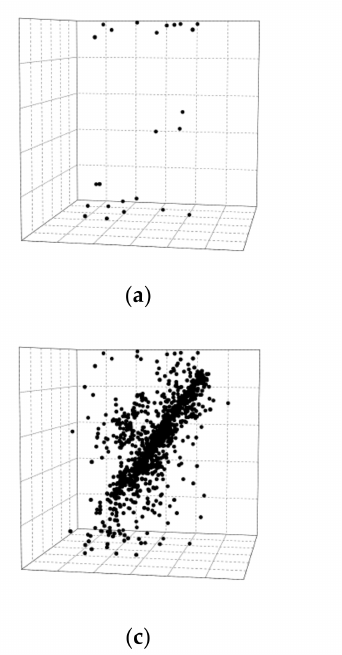
Figure 2. Evolution of AE centers. ( a ) A few AE centers appear in the top and bottom areas of a sandstone sample since friction between sample faces and loading faces; ( b ) some AE centers occur randomly; ( c ) AE centers form the final crack; and ( d ) the image of the cracked sample. Reproduced with permission from [54]. De Gruyter, 2016.